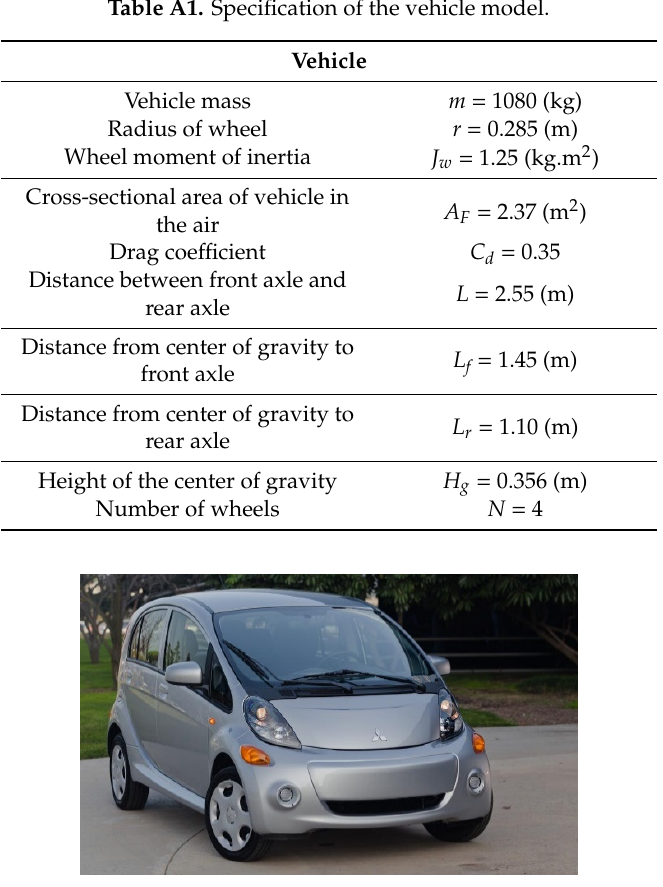
Figure A1. Electric vehicle for establishing the simulation model.